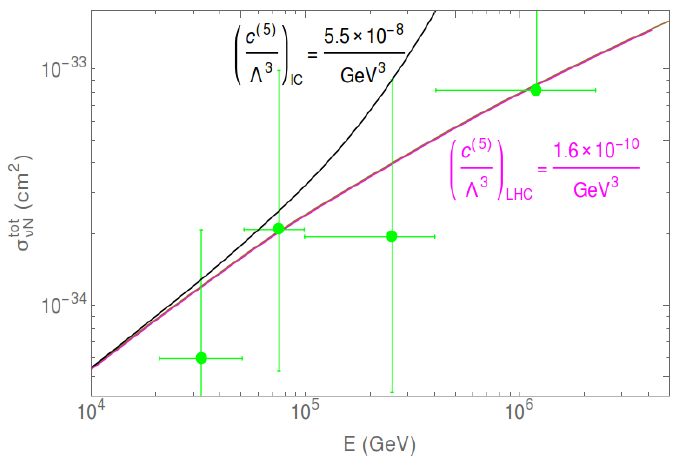
Figure 8 . Constraints on NSI appearing in eq. (4.8). Colour coding is the same as in (cid:12)gure 1. from (cid:12)gures 5, 6, 7 and 8, the measurement of (cid:27) tot